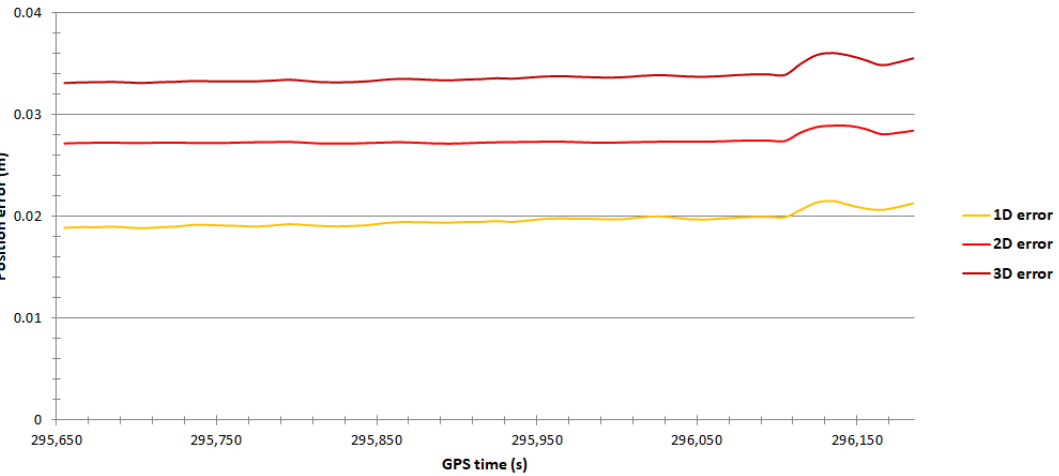
Figure 8. Variability in position errors recorded by the GNSS/INS system in the RTK mode in section no. 1.